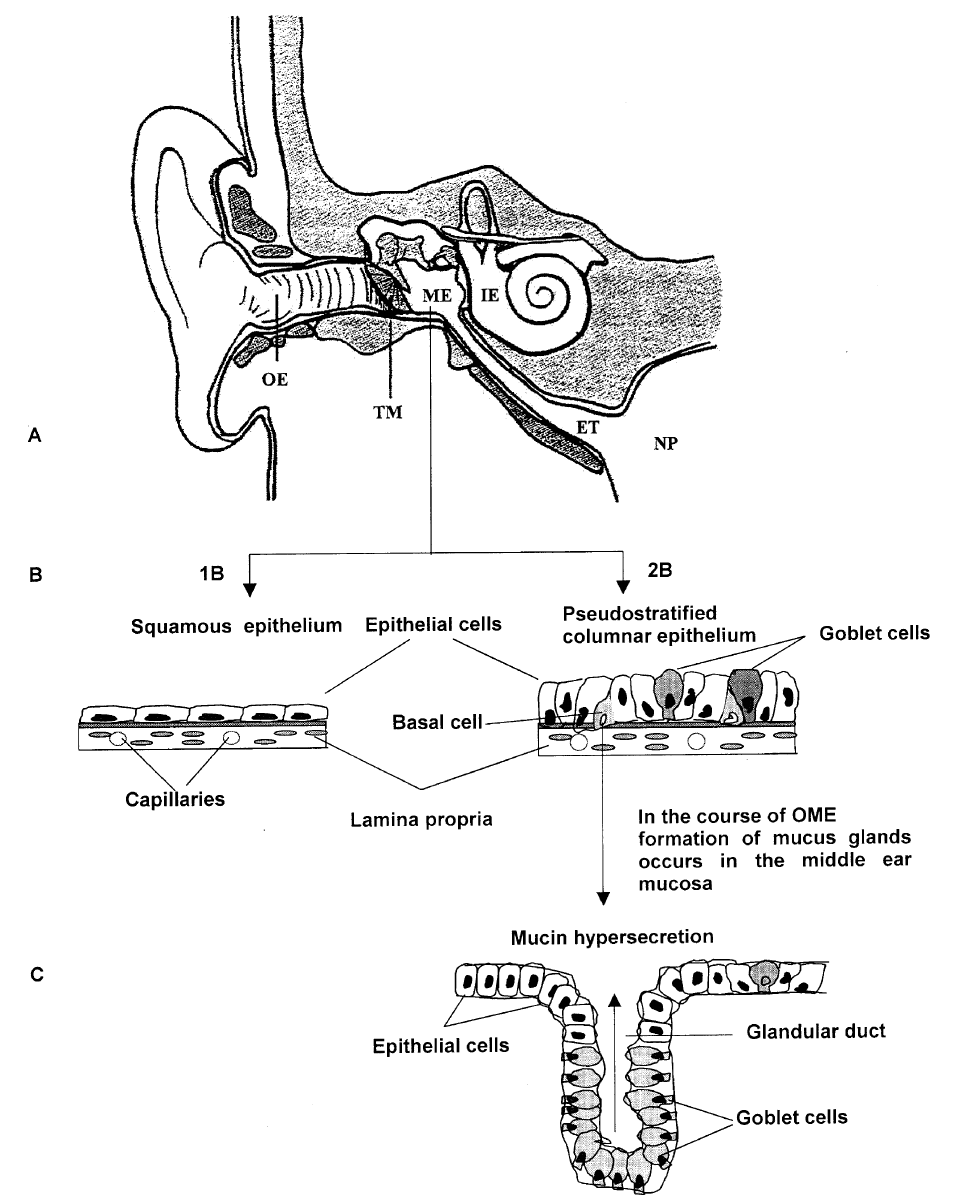
FIG. 1. Anatomy of the ear, schematic structure of the middle ear epithelium and mucus gland. (A) Anatomy of the ear: OE, outer ear; ME, middle ear; IE, inner ear; TM, tympanic membrane; ET, Eustachian tube; NP, nasopharynx. (B) There are two types of epithelium in the middle ear. The major part of middle ear is lined with simple squamous epithelium (1B). Near the Eustachian tube, epithelium of the middle ear is gradually transformed into pseudostratified columnar type (2B), some of which is ciliated. (C) Schematic structure of the mucus gland in the middle ear mucosa. Mucus glands develop as basal cells grow down into the lamina propria and differentiate into goblet